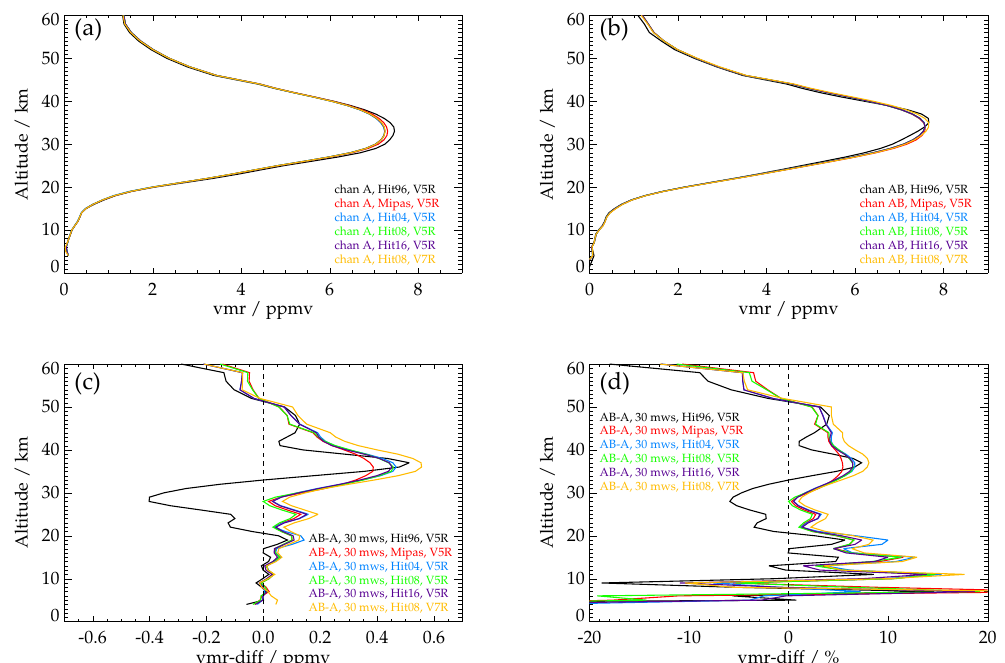
Figure 5. (a) Average ozone profiles retrieved in MIPAS channel A using V5R spectra and different spectroscopies: HITRAN-1996 (black), MIPAS pf3.2 (red), HITRAN-2004 (blue), HITRAN-2008 (green) and HITRAN-2016 (violet). The yellow curve shows the average profile for V7R spectra and application of the HITRAN-2008 line list. (b) Same as A, but for MIPAS channel AB. (c) Absolute and (d) relative differences between the profiles retrieved in channels AB and A. The ozone profiles were averaged over all single-scan profiles of 59